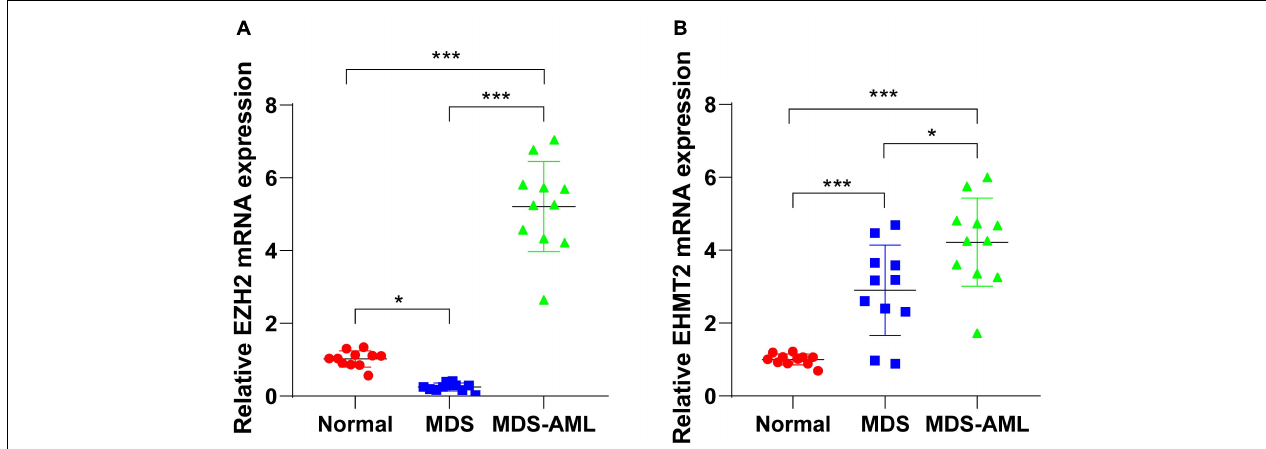
FIGURE 1 | EZH2 and EHMT2 were upregulated in MDS patients and MDS-AML patients. (A,B) Expressions of EZH2 and EHMT2 in bone marrow of MDS patients, MDS-AML patients, and non-cancer individuals were detected using RT-qPCR. Each experiment was repeated three times. Data are analyzed using one-way ANOVA, followed by Tukey’s multiple comparisons test, * p < 0.05, *** p < 0.001.